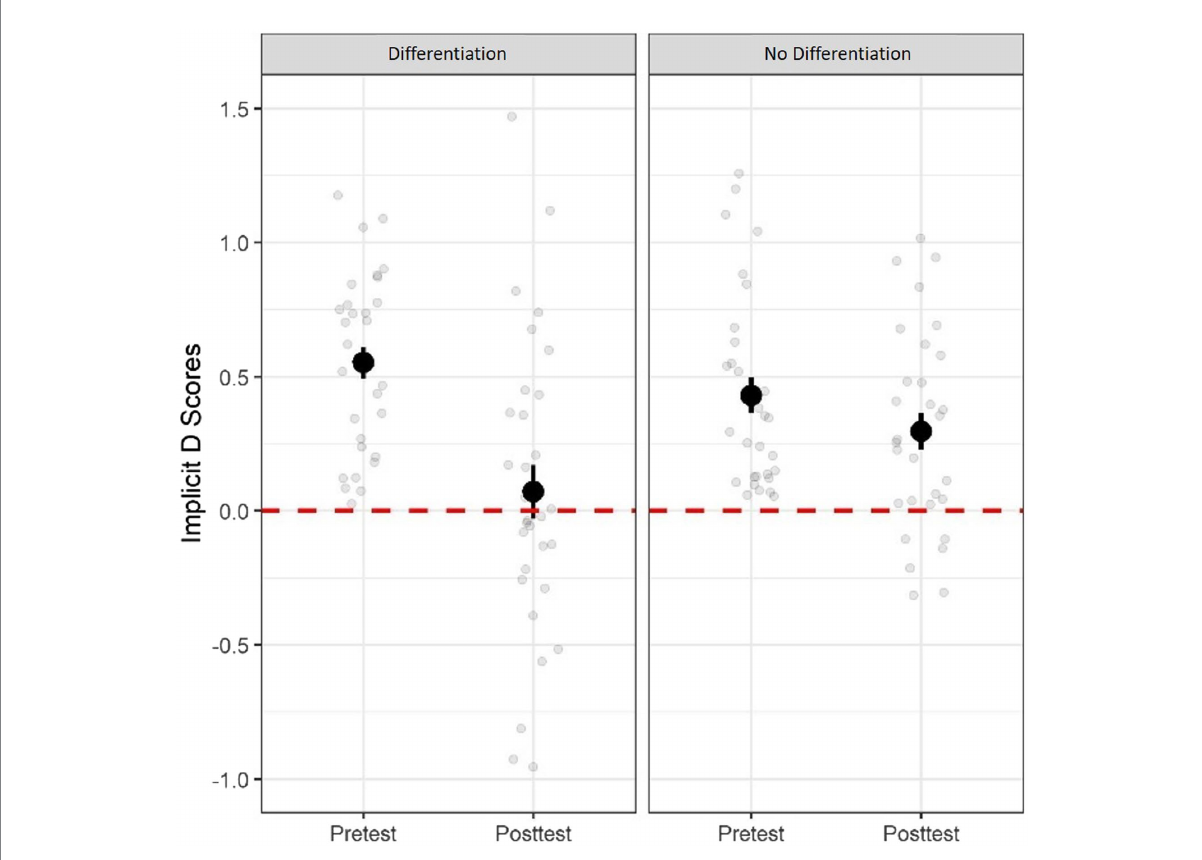
FIGURE 1 Implicit racial bias at pretest and posttest for the differentiation and no-differentiation conditions. Grey dots represent each participant’s score. Error bars represent standard errors. Red dashed lines represent no